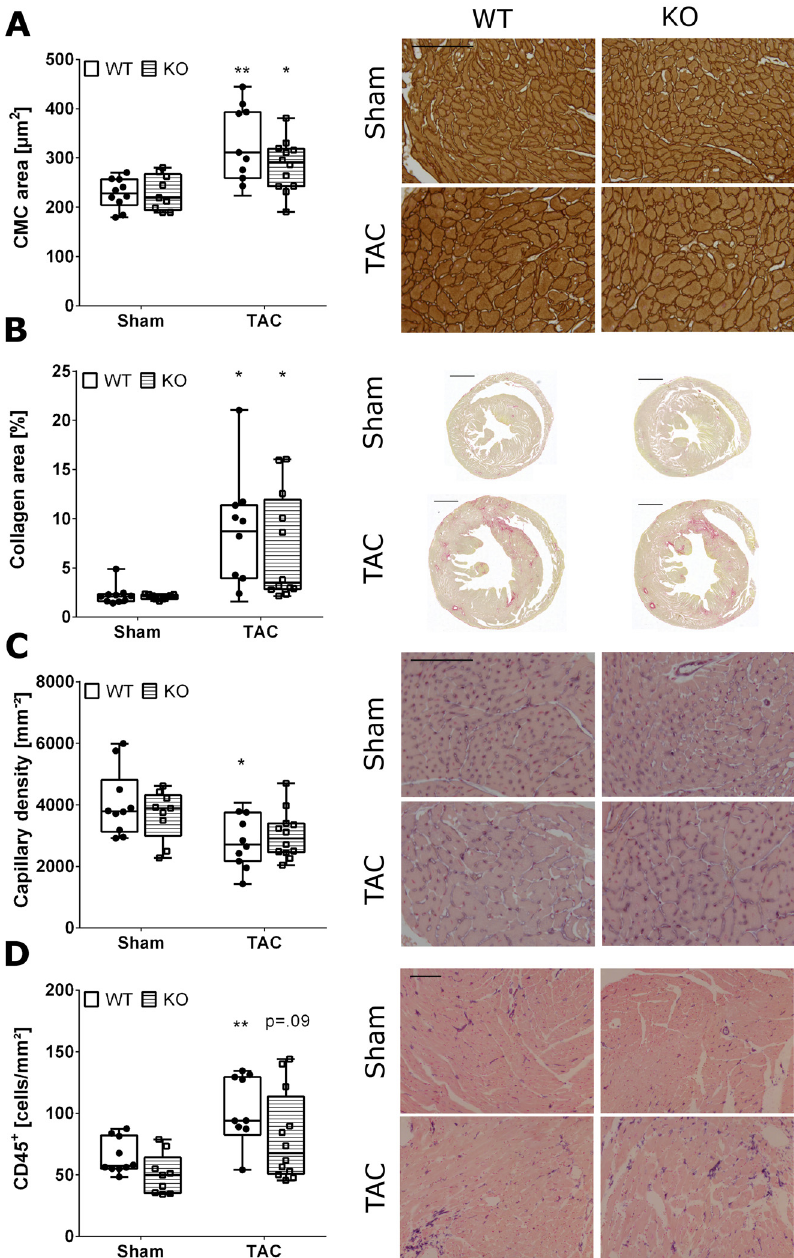
Fig 2. Histological analysis of LV and septal myocardium after TAC. Significant cardiomyocyte hypertrophy (A) and interstitial fibrosis (B) were induced by TAC, whereas the density of endocardial capillaries was mildly decreased (C). (D) Infiltration of CD45 positive leukocytes was apparent after TAC, although this did not reach statistical significance in Malat-1 KO mice. Importantly, no significant differences could be detected between Malat-1 WT and KO mice for any of the histological parameters. * p < 0.05, ** p < 0.01 TAC versus Sham. Scale bars: Sirius Red: 1 mm; all other stains: 100 μ m.